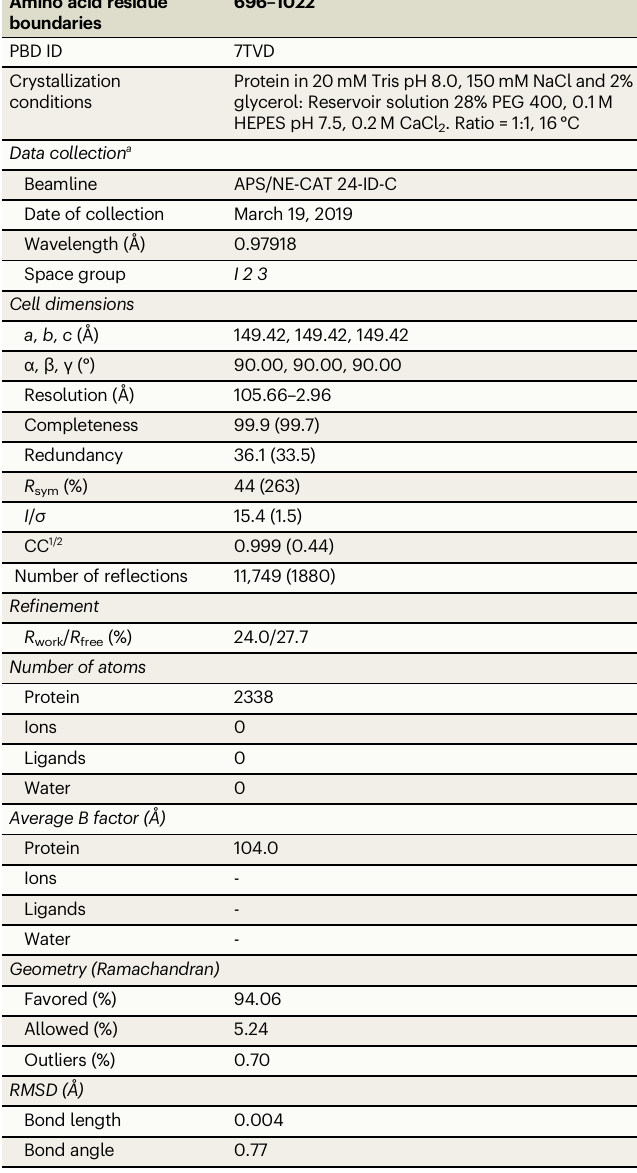
Table 2 | Crystallization conditions, data collection, and re fi nement